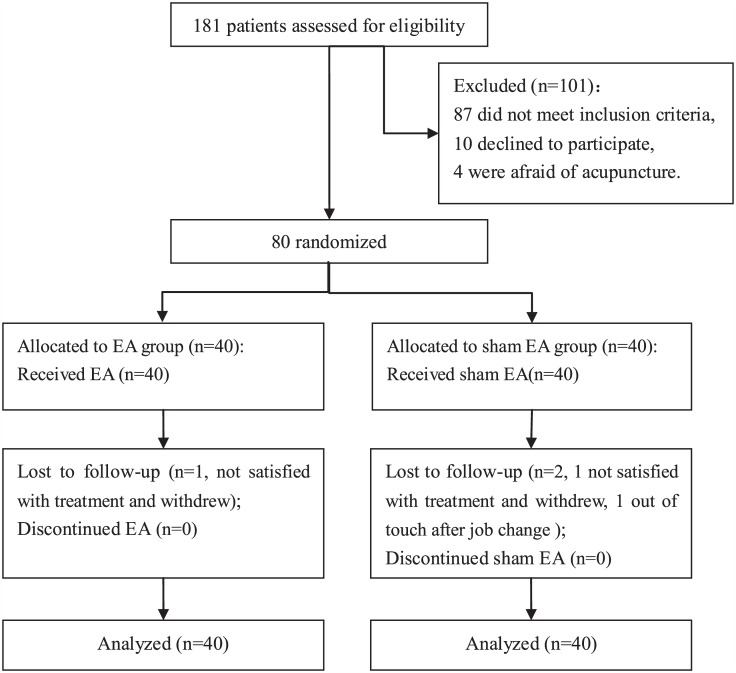
Flow diagram of participants.The flow chart of this study according to the CONSORT Statement.